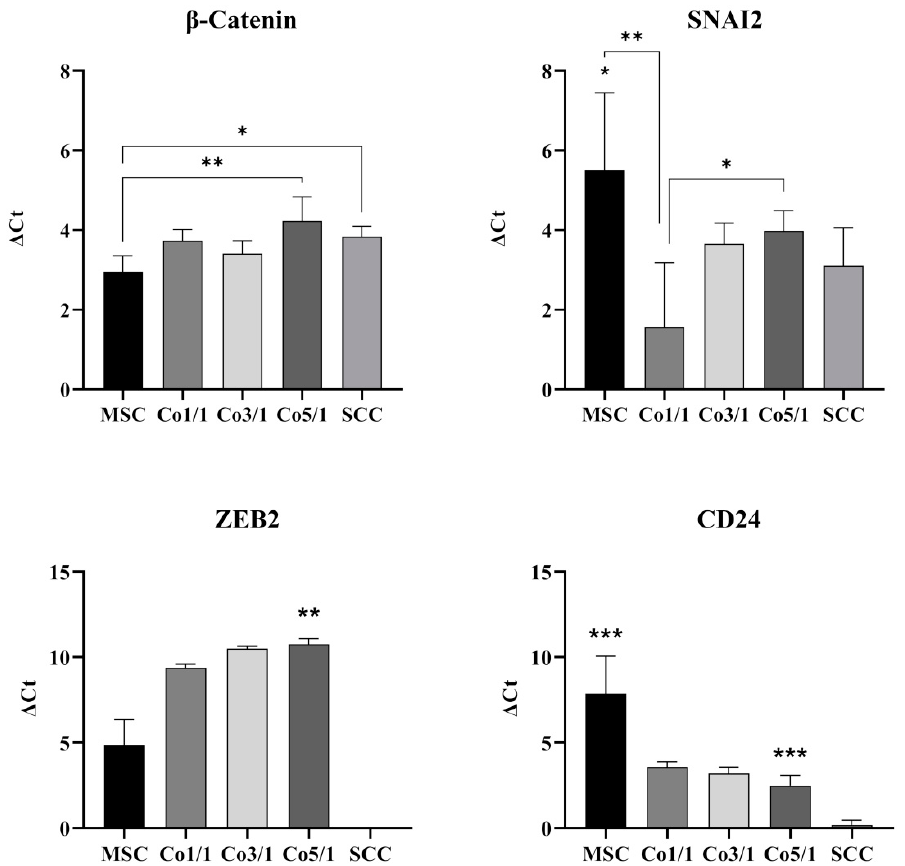
Figure 5. RT-qPCR analysis of β -catenin, SNAI2, ZEB2, and CD24 in MSCs, Co1/1, Co3/1, Co5/1, and SCCs (*** = p ≤ 0.01, ** = p ≤ 0.01, * = p ≤ 0.05).